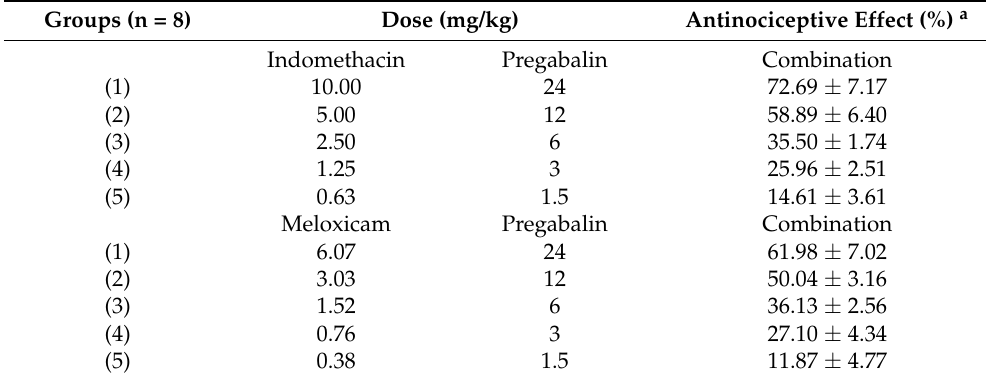
Table 1. Doses of indomethacin or meloxicam combined with pregabalin in paclitaxel-induced neuropathic pain in